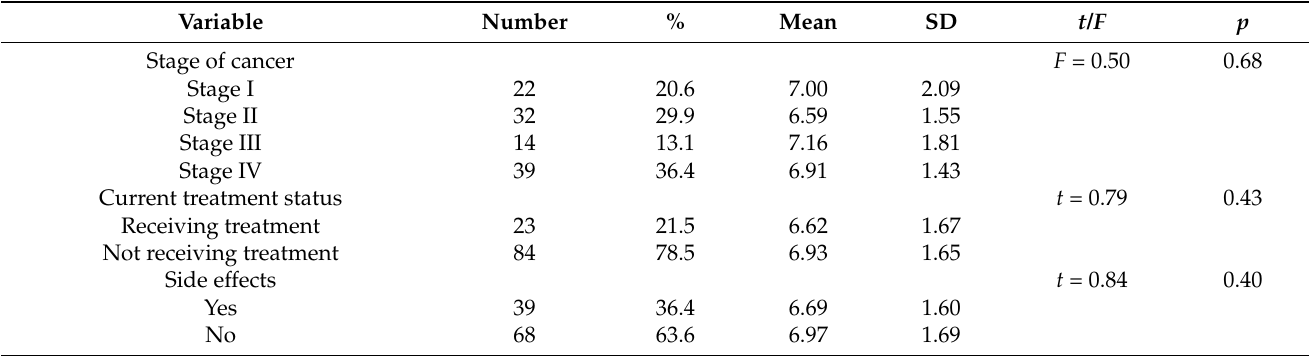
Table 2. Patients’ medical characteristics and the differences in overall caregiving self-efficacy between or among groups ( n = 107).